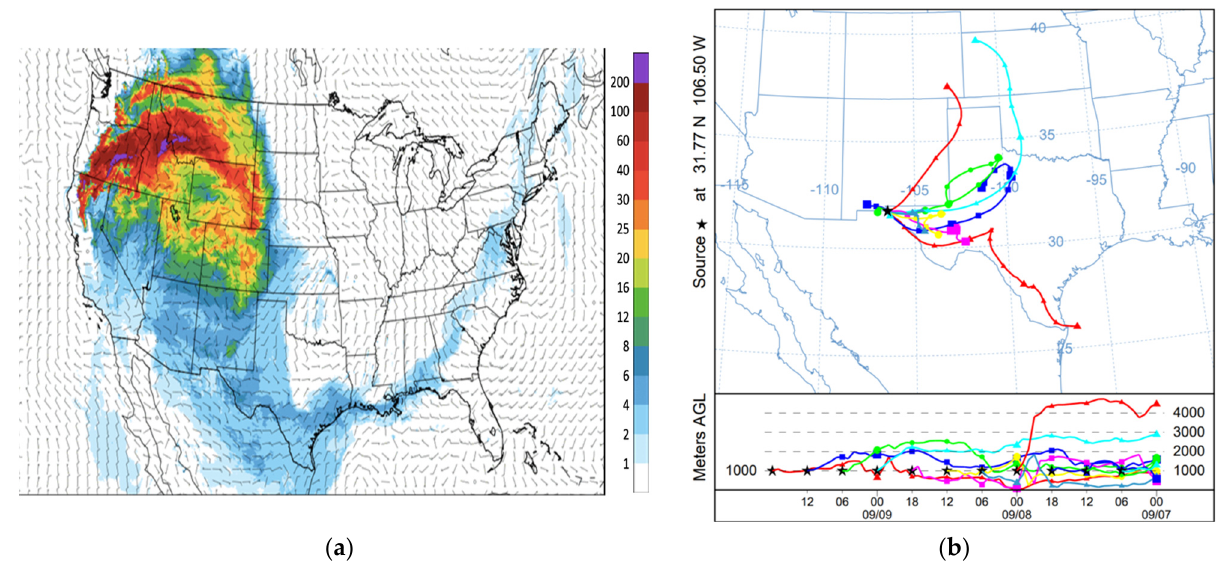
Figure 13. The HRRR and HYSPLIT analyses for 9 September 2021. ( a ) The HRRR map indicates the surface mass concentration, from purple at the origin of the wildfire (northern California and south Oregon) to light blue at its lowest concentrations. El Paso, located at the western corner of the state of Texas received 2 to 8 micrograms per cubic meter of PM 2.5 . ( b ) The HYSPLIT backward trajectories run for 72 h at height 1, 1.5 and 2 km from the surface.